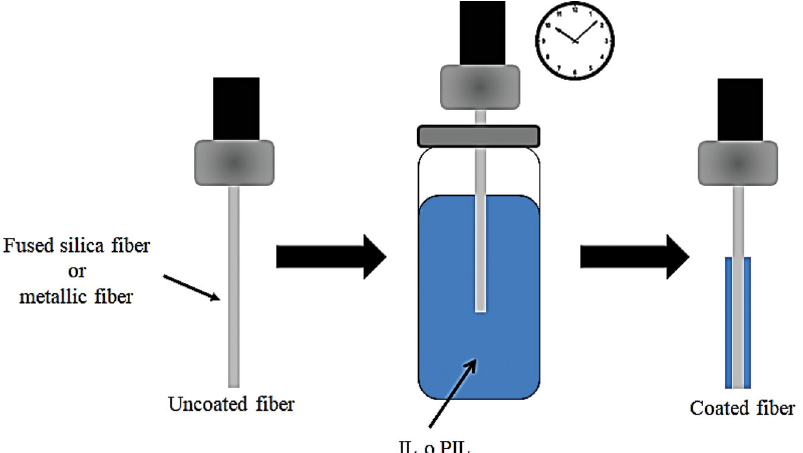
Figure 2: Immersion-agglutination coating procedure to obtain SPME